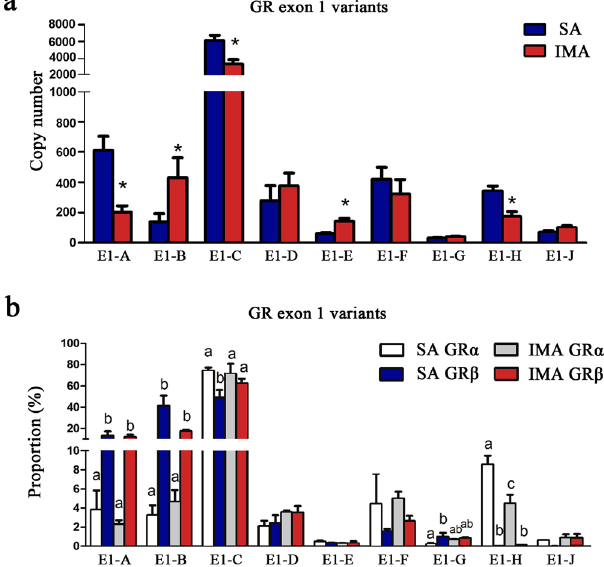
Figure 3. Expression patterns of GR exon 1 variants. ( a ) Copy number of GR exon 1 variants in SA and IMA tissues. n = 12 per group, * P < 0.05. ( b ) Variants proportion of GR α and GR β in SA and IMA tissues. n = 6 per group, within column the different lowercases mean significant difference (One-way ANOVO, P < 0.05) within the columns, and the same lowercase means no significant difference (One-way ANOVO, P >